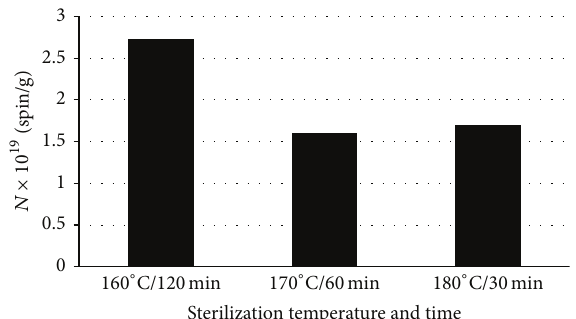
Figure 6: Free radical concentrations ( 𝑁 ) in bismuth subgallate thermally sterilized at 160 ∘ C (120 minutes), 170 ∘ C (60 minutes), and 180 ∘ C (30